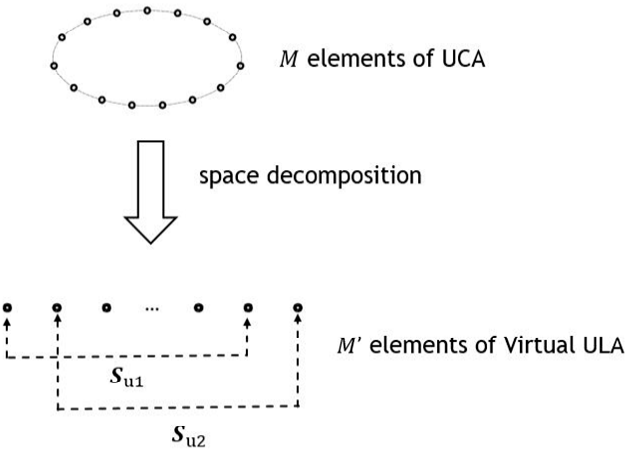
Figure 2. Conversion from UCA to virtual ULA.